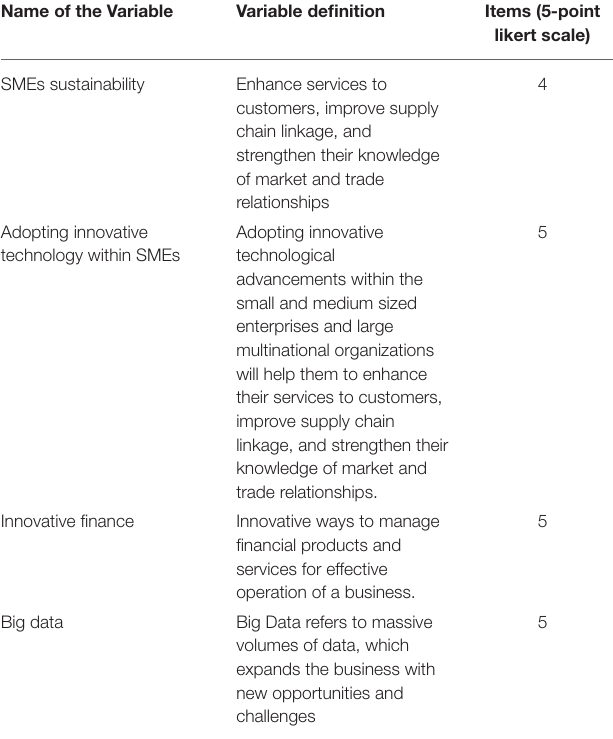
TABLE 2 | Variables of the